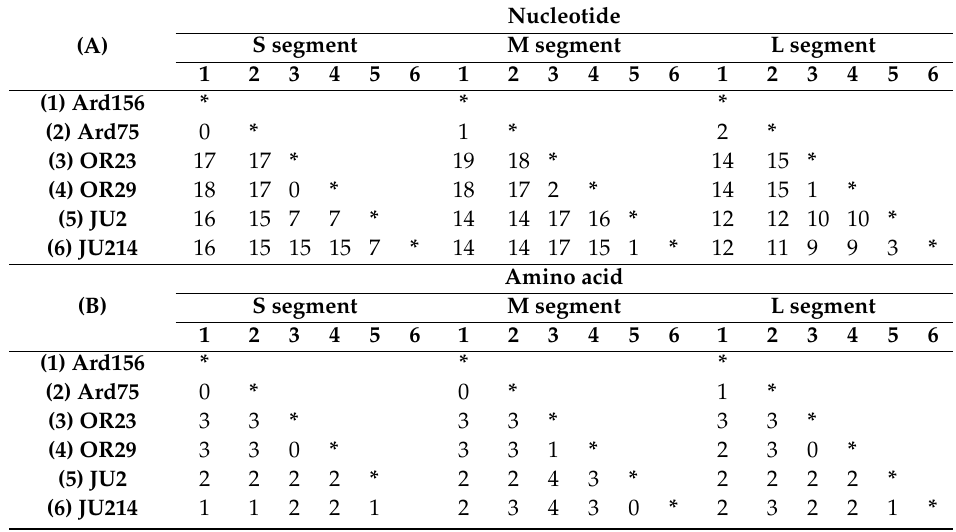
Table 2. Evolutionary divergence between French PUUV isolates nucleotide sequence ( A ) and amino acid sequence ( B ) levels. The results are expressed in percentage (%) of divergence. * : not tested.